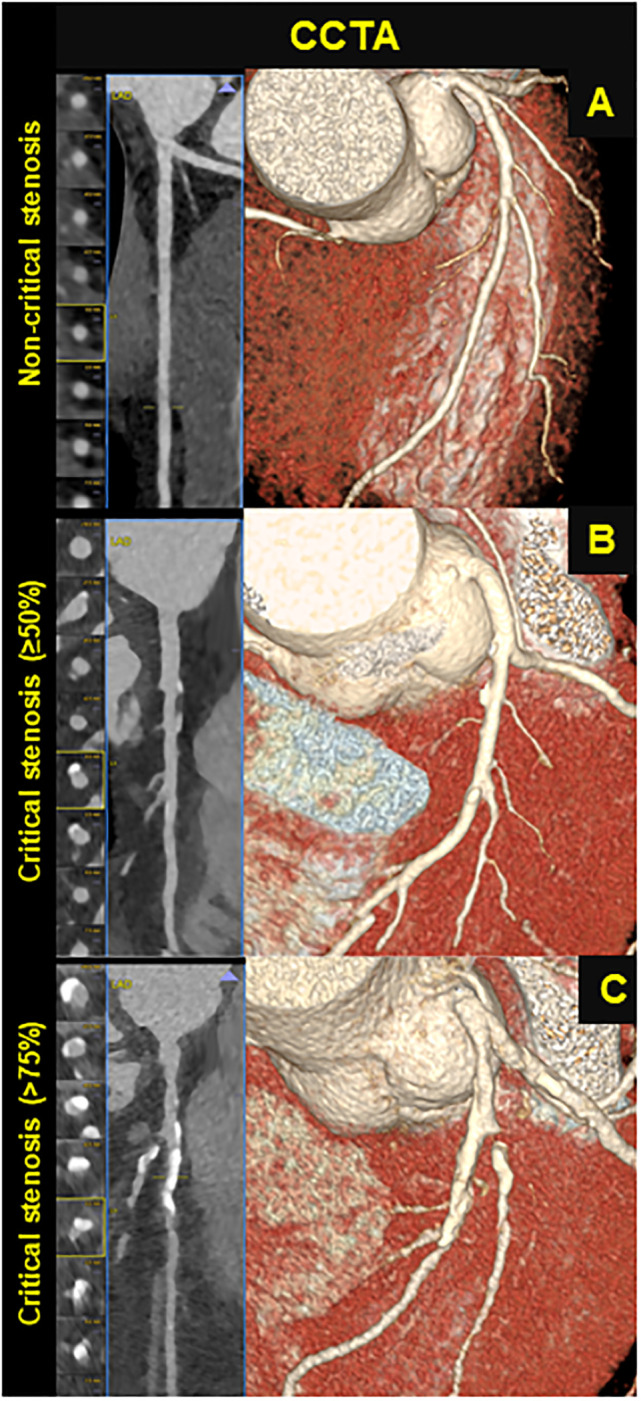
CCTA screening.CCTA analysis in subjects screened for suspected CHD. Panel A shows a subject with non-critical stenosis (<50); Panel B a patient with a critical stenosis ≥50%; Panel C a patient with a critical stenosis>75%.